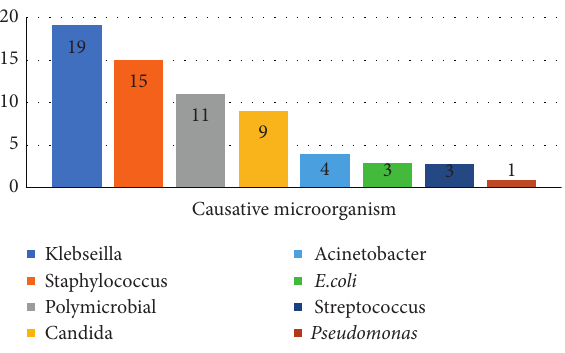
Figure 1: The distribution of the causative